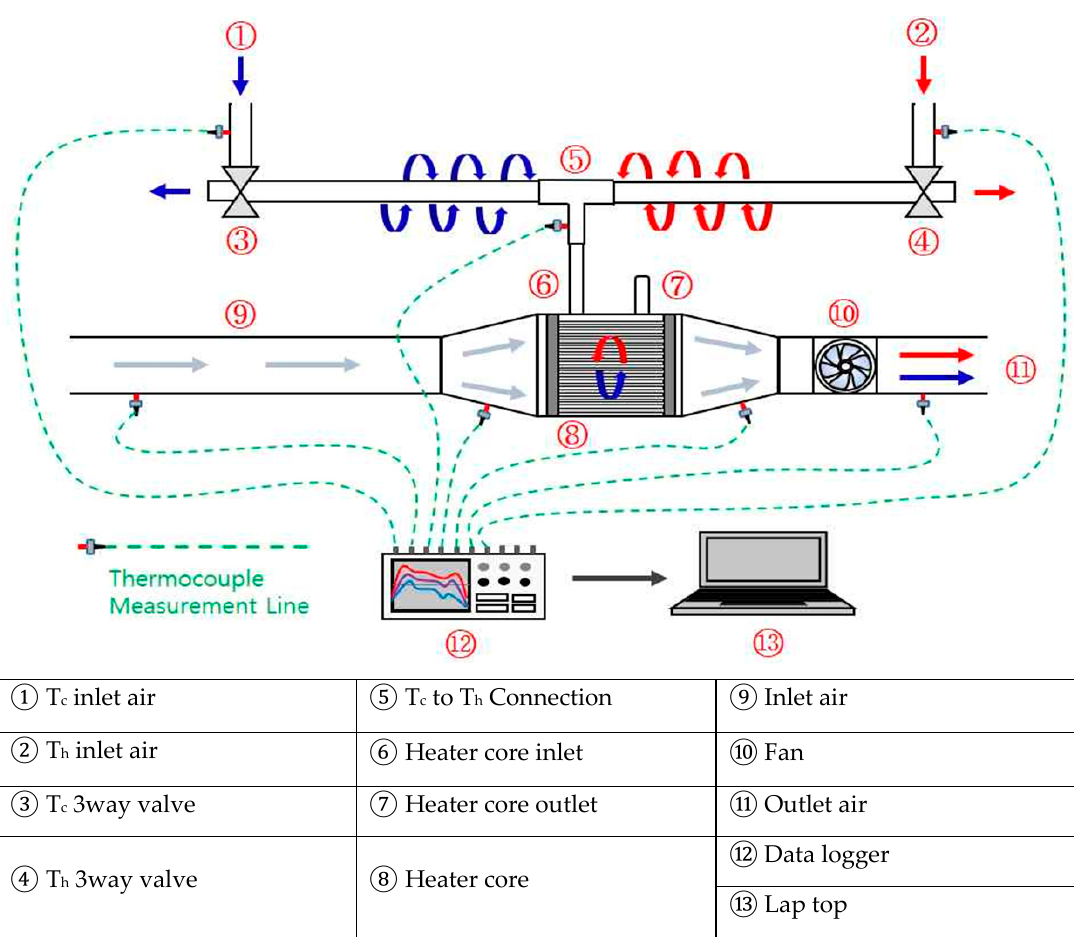
Figure 7. Schematic diagram of the indirect heater core. Energies 2020 , 13 , x FOR PEER REVIEW